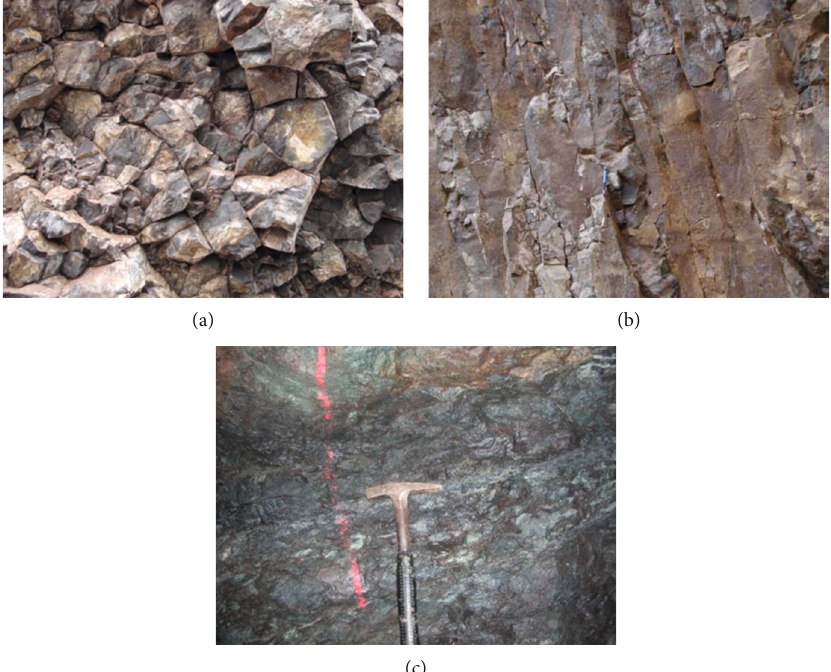
Figure 4: Typical columnar jointed rock at Baihetan dam site: (a) strongly weathered, (b) slightly weathered, and (c) fresh.